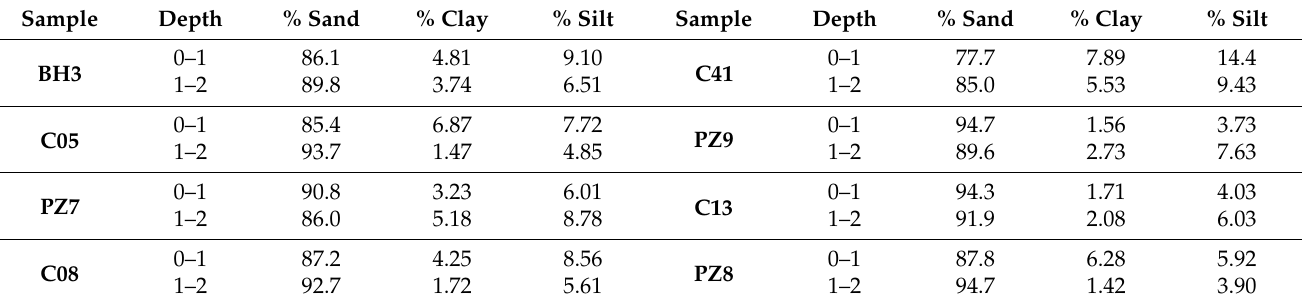
Table 2. Soil texture (sand, clay, silt) of the soil samples expressed as percentages.